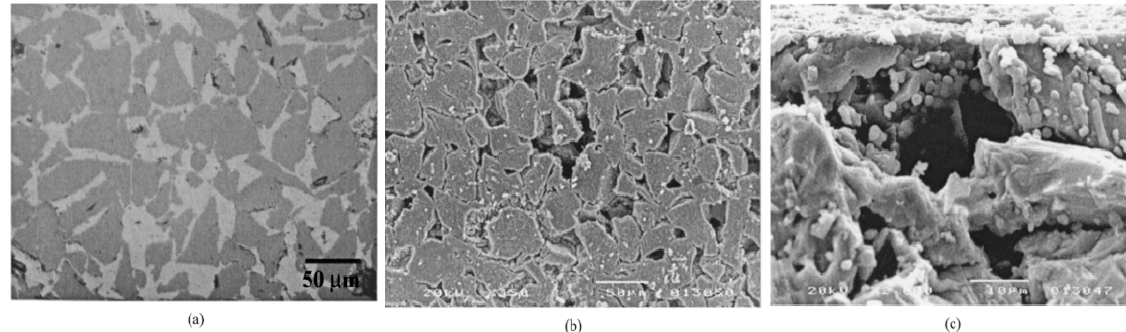
Figure 32. Optical micrograph of the RBSC specimen before corrosion test ( a ) and SEM micrographs of the surface ( b ) and the cross-section ( c ) of the same specimen after corrosion at 360 °C for 7 days. Reprinted with permission from Reference [99]. Copyright 2002 Springer Nature.